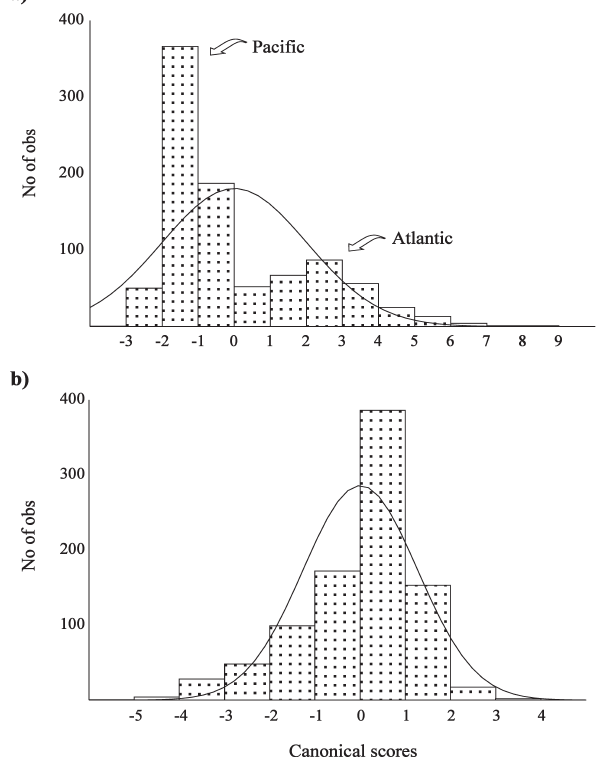
F IG . 3. – Discrimination analysis with the normalization of individ- uals of each group: a). Combined histogram for the canonical scores for the Pacific and Atlantic groups using nine morphometrics vari- ables and b) Combined histogram for the canonical scores for the Pacific and Atlantic groups using eight morphometrics variables (without ocular diameter) for Mugil curema . Continuous line is the expected